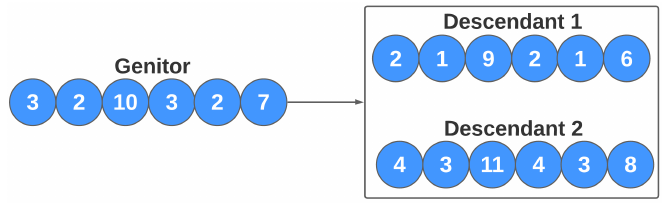
Figure 8. Asexual reproduction for the genetic